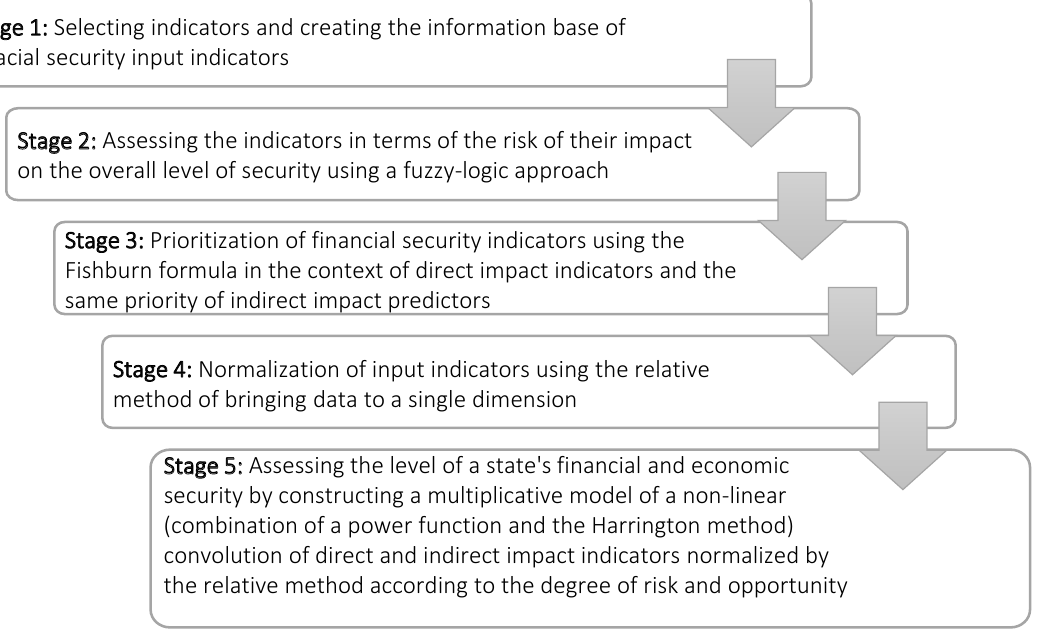
Figure 1. Stages of implementing the model to assess a country’s financial security